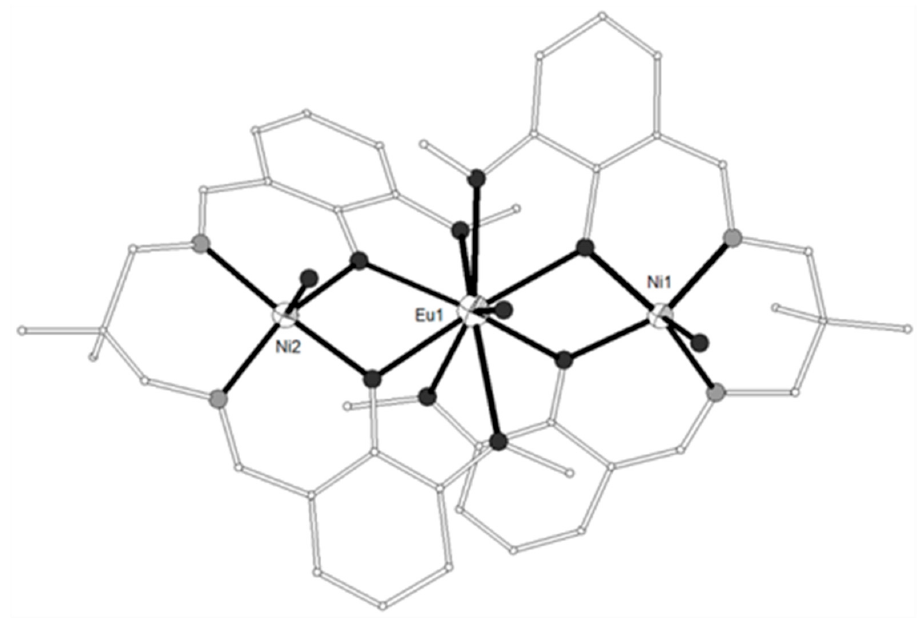
Figure 10. The molecular structure of the cation [{NiL 19 (H 2 O)} 2 Eu(H 2 O)] 3+ in complex 93 . Color code as in Figure 2 [40].